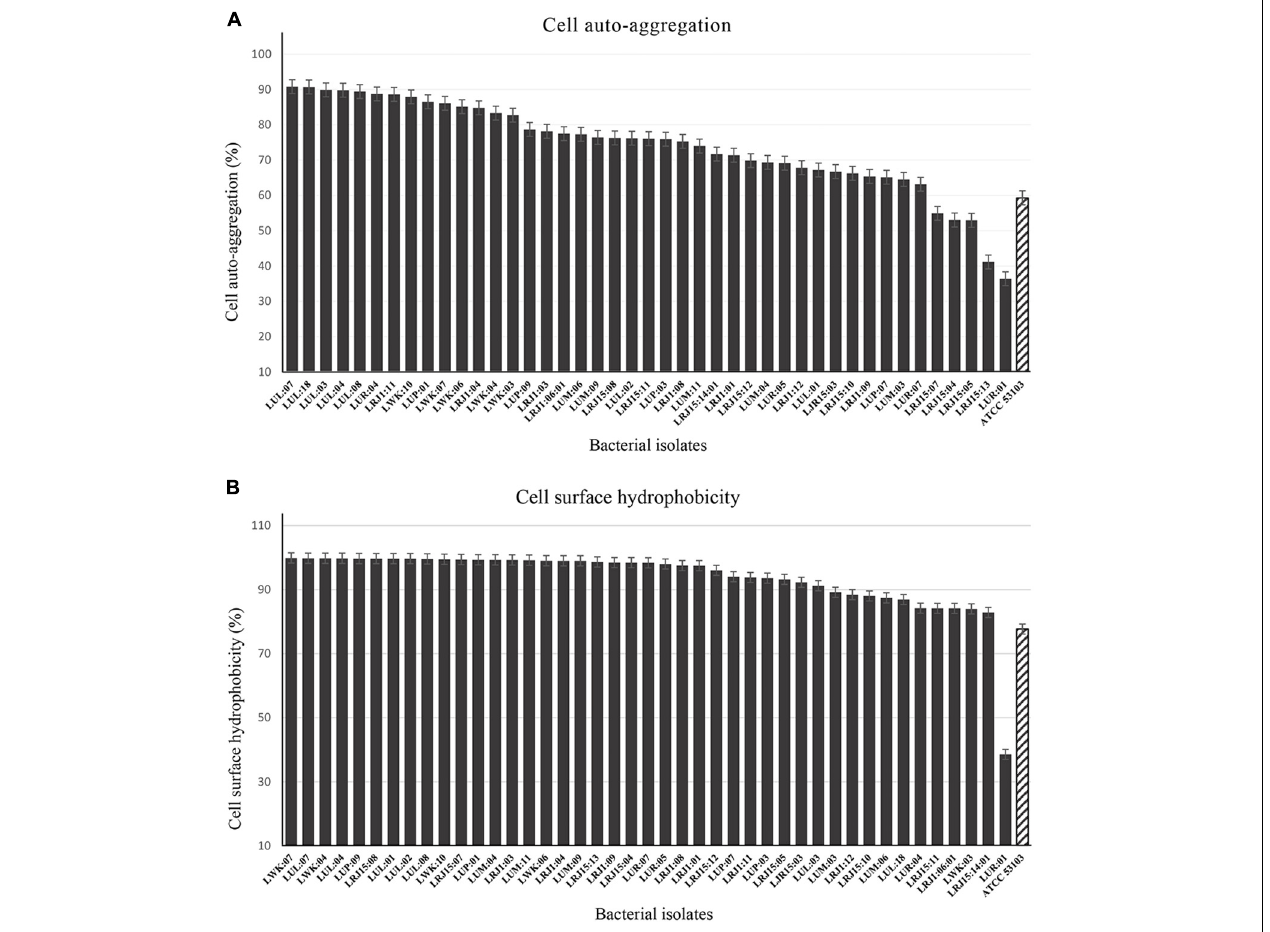
FIGURE 2 | Cell auto-aggregation and cell surface hydrophobicity activity of bacterial isolates after 24 h. (A) The adhesion characteristics with cell auto-aggregation test (%) of bacterial isolates after 24 h with reference control Lacticaseibacillus rhamnosus (ATCC 53103). (B) Adhesion properties characterized with cell surface hydrophobicity test (%) of bacterial strains against n-hexadecane with reference control L. rhamnosus (ATCC 53103). Error bars and standard deviations showed with respect to the mean ± S.D. values of triplicate